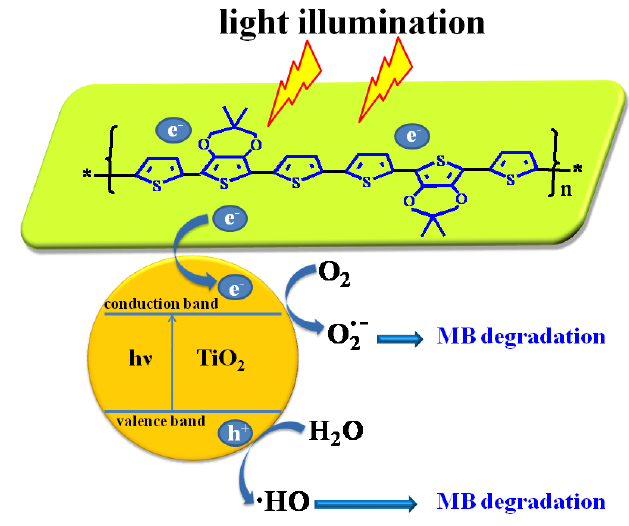
Figure 8. A schematic illustration of the photocatalytic activity of a nanocomposite (take the poly(TMPT)/TiO nanocomposite for 2